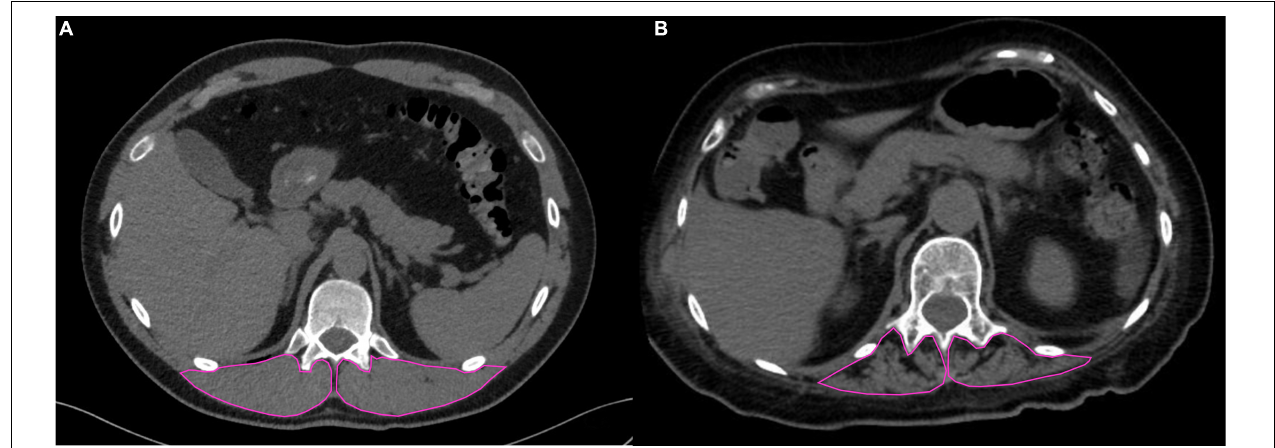
FIGURE 1 | Chest CT images at the T12 level in two patients with COVID-19 pneumonia. In (A) (30-year-old man), the skeletal muscle area segmented at the T12 level is characterized by normal mass and high mean SM-RA (56.5 HU); in (B) (72-year-old woman), impaired muscle status is evident, with fat infiltration and low mean SM-RA (11.1